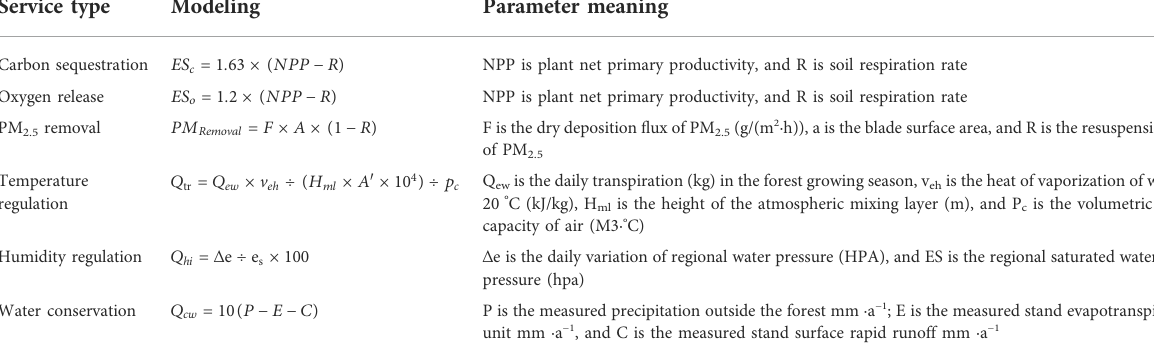
TABLE 1 Evaluation method of ecosystem services.